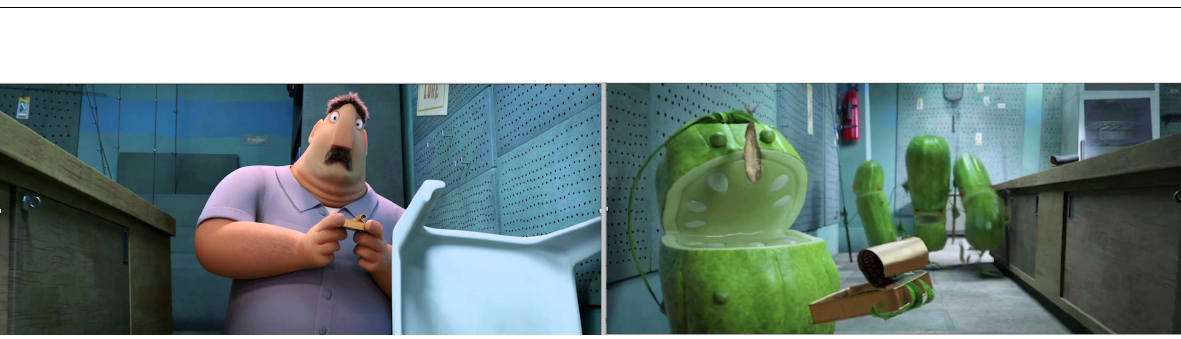
Figure 4: Tim Lockhart contemplates his edibility upon encountering a carnivorous pack of pickles ( Cloudy 2